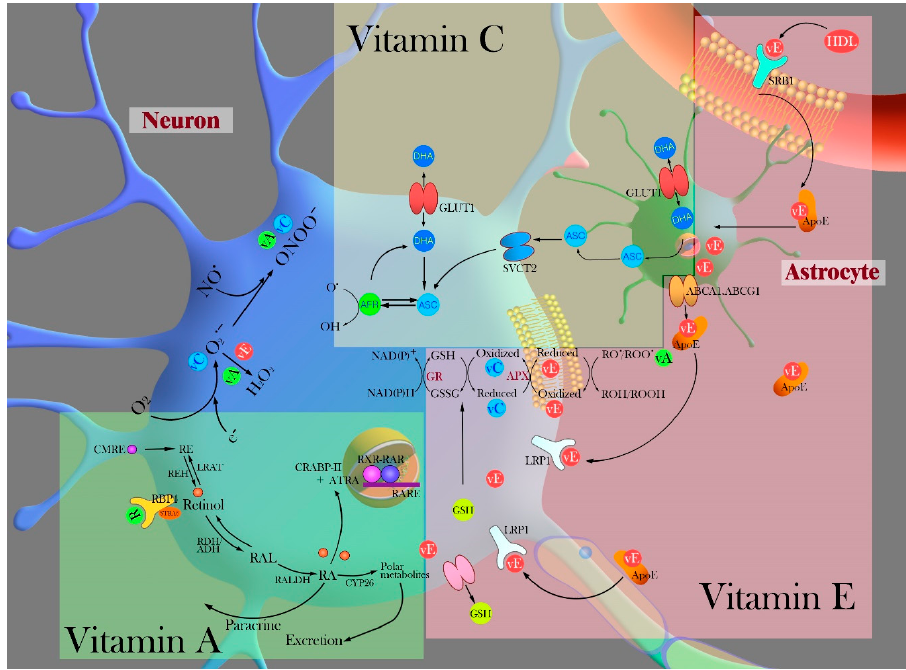
Figure 3. Schematic representation of vitamin uptake and protective mechanisms by exogenous vitamins as antioxidants. Vitamin C: During uptake in the CNS, ascorbate passes through the BBB to enter directly through the SVCT-2 and/or possibly DHA through GLUT1s. Moreover, the neuronal uptake of ascorbate occurs through SVCT-2 and DHA via the GLUT1s. In the neuron, DHA can be reduced to ascorbate or released back into the extracellular space by GLUT1. Ascorbate free radicals convert to form DHA and ascorbate. Ascorbate recycles both the ascorbate free radical and DHA by cellular metabolism. Astrocytes contain ascorbate from recycling of DHA which is taken up through GLUT1s. Neurons directly acquire ascorbate via SVCT-2. Vitamin E: With respect to vitamin E uptake, HDL particles can pass through SRB1 receptors expressed on endothelial cells. Astrocytes that exist adjacent to the BBB take up vitamin E into the inner cell membrane. Synthesized ApoE lipoproteins take up vitamin E that is left out of an ABC transporter, for transport into neurons through LRP1 requiring vitamin E for maintenance or during conditions of oxidative stress. Vitamin A: In cellular retinoid signaling pathways, retinol is metabolized to all-trans-retinoic acid (ATRA). Vitamin A (retinol, ROL) binds to plasma retinol binding protein (RBP4) and circulates; RBP4 protein binds to the membrane receptor STAR6 to promote cellular absorption of retinol from the cells. A chylomicron remnant (CMRE), as a form of circulating vitamin A, can serve as a source of vitamin A for the cells and retinol is esterified and stored by lecithin: retinol acyltransferase (LRAT) and is reversibly oxidized to retinaldehyde (RAL) by retinol dehydrogenase (RDH/ADH). In addition, retinol is further oxidized to RA in an irreversible manner by retinaldehyde dehydrogenase (RALDH). ATRA regulates gene transcription through retinoic acid receptors (RAR) and/or retinoid X receptors (RXRs) which are bound to retinoic acid response elements (RARE) in the nucleus. These representative schematics are modified from [130,154,161]. Abbreviations: VC, vitamin C; VE, vitamin E; VA, vitamin A; ASC, ascorbate; ASF, ascorbate free radical; DHA, dehydroascorbic acid; GLUT1, glucose transports; SVTC-2, sodium-dependent transporters; LRP, lipoprotein receptor-related protein; GSH, glutathione; ApoE, apolipoprotein E; HDL, density lipoprotein; CMRE, chylomicron remnant; CRABP, cellular retinoic acid-binding protein; LRAT, lethicin: retinol acyltransferase; RBP, retinol binding protein; RAL, retinaldehyde; RDH / ADH, retinol dehydrogenase; RALDH, retinaldehyde dehydrogenase; RXR, retinoid X receptors; RAR, retinoic acid receptors; ATRA, all-trans-retinoic acid; BBB, blood–brain